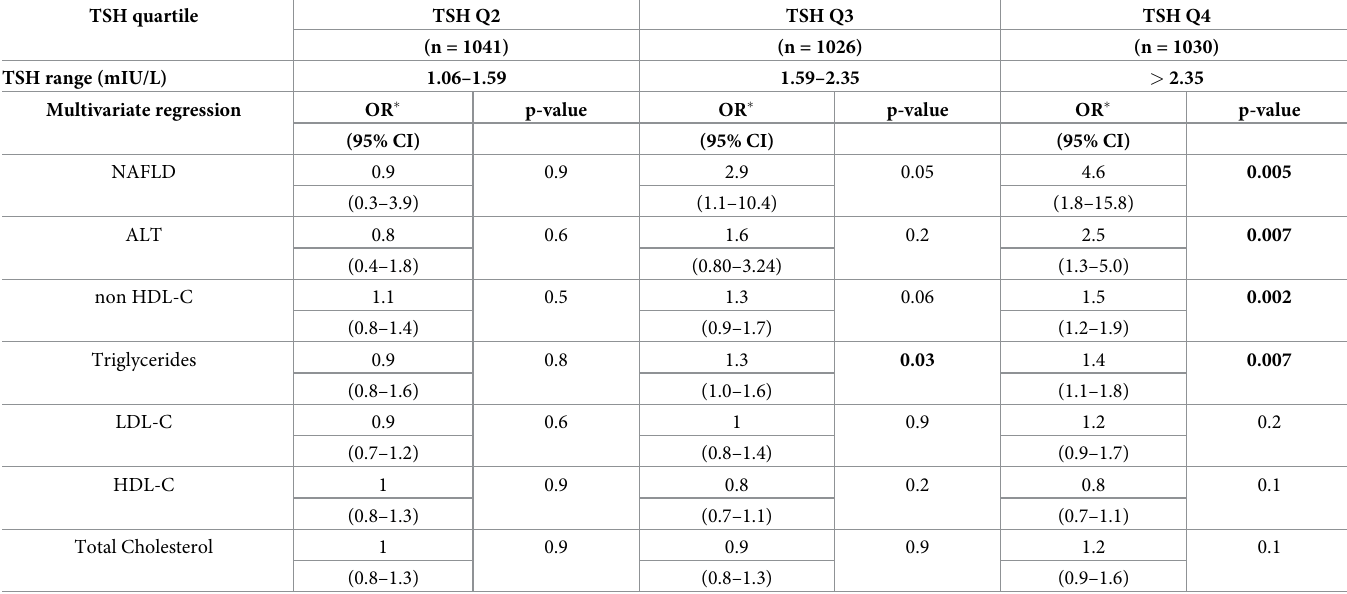
Table 2. Association between TSH and NAFLD, ALT and lipoproteins. TSH quartile TSH